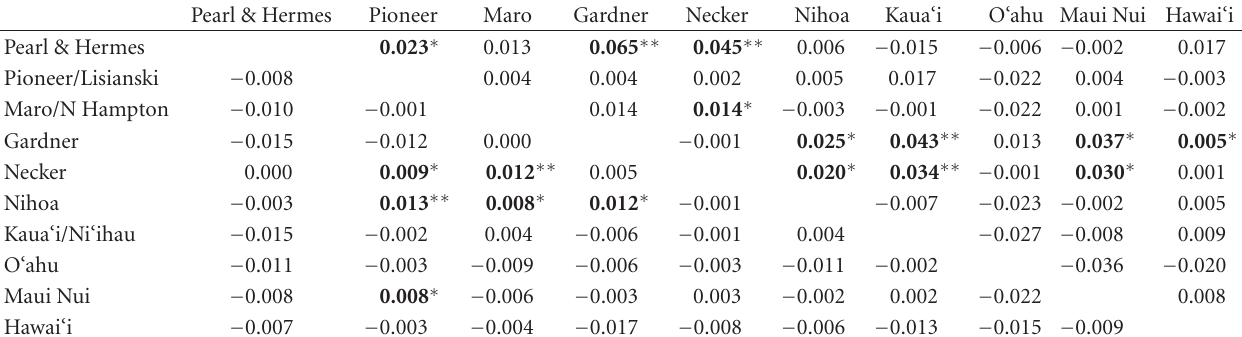
Table 3: Pairwise F ST values for 8 microsatellite loci (below diagonal) and pairwise Φ ST values for mtDNA control region sequences (above diagonal) for E. quernus between locations in the Hawaiian Archipelago. MtDNA data is from Rivera et al. [25]. Bolded numbers indicate significant values: ∗ P < . 05, ∗∗ P < . 01.